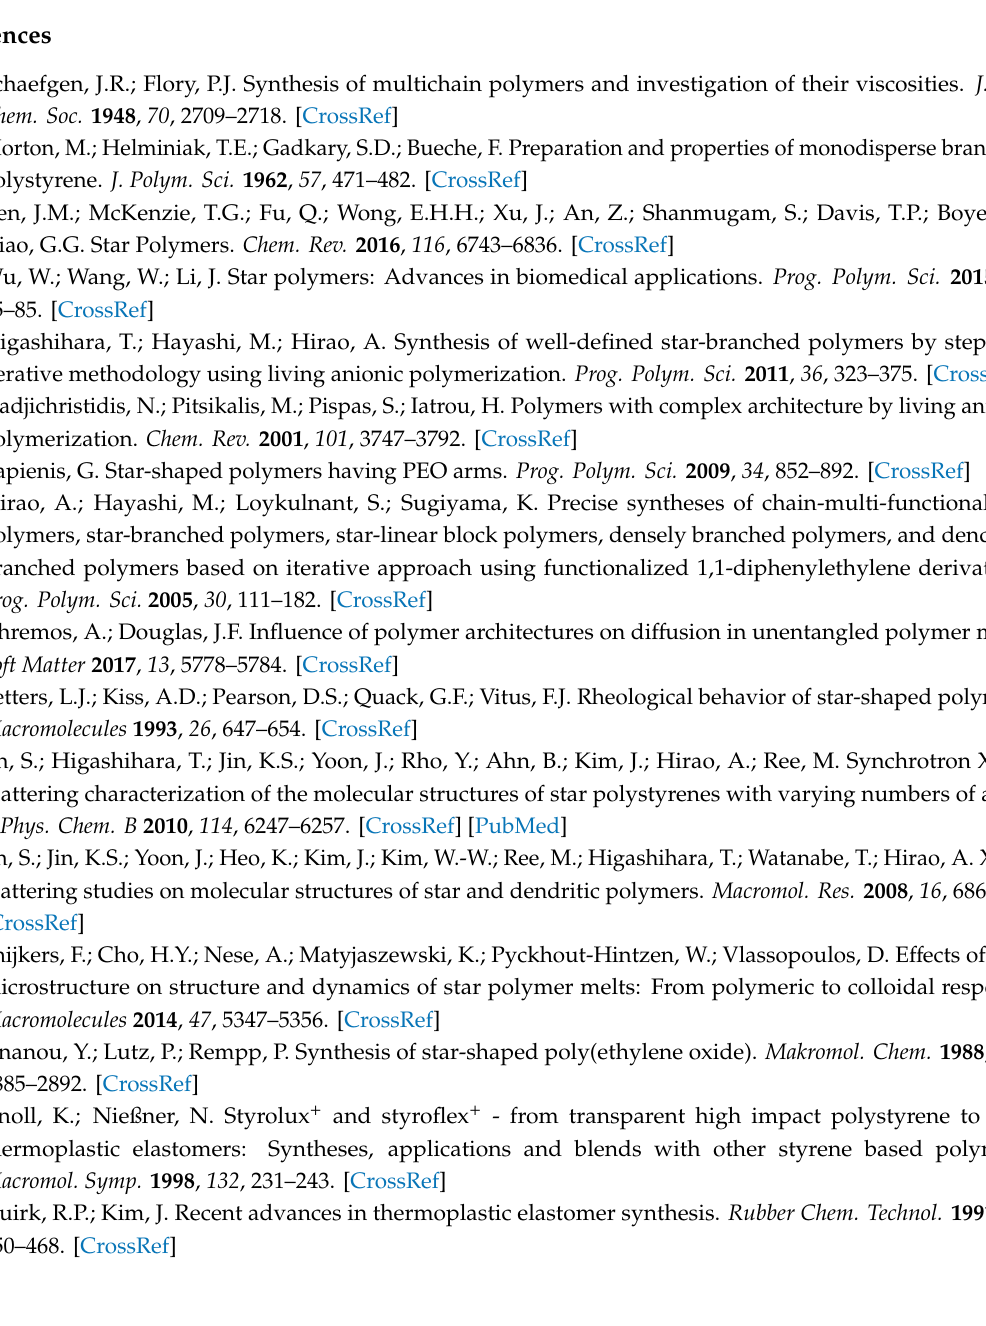
Figure S1. Pair distance distribution functions p ( r ) obtained from numerical Fourier transformation of the extrapolated scattering intensity profiles obtained by the model analysis: (a, b) CHX at 35.0 ◦ C ( Θ condition); (c, d) THF at 25.0 ◦ C (good